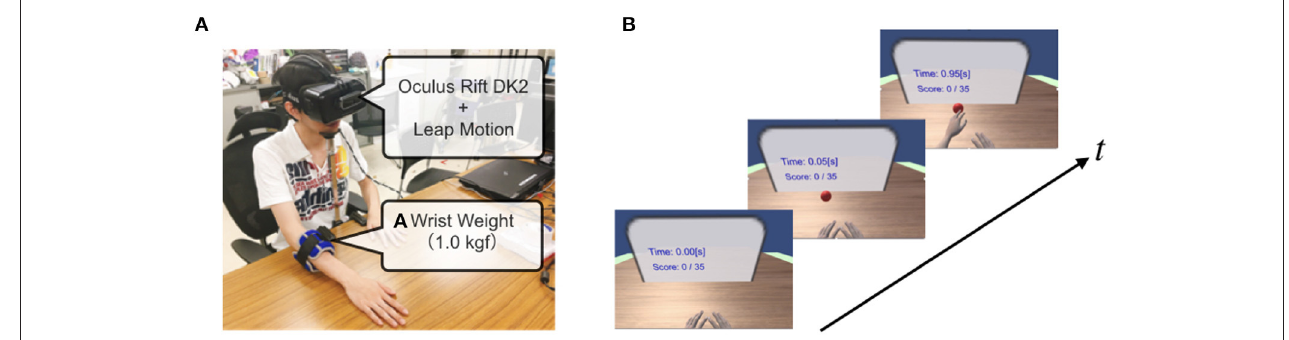
FIGURE 1 | Immersive Virtual Reality system integrated with motion capture. (A) A 1.0 kg wrist weight was attached to the distal portion of the dominant forearm of the healthy participant to simulate the affected upper limb of stroke patients. A head-mounted display (HMD) was attached to the head with a strap, and a motion capture system (Leap motion) was attached to the front part of the HMD. (B) The participant placed their hands at the home positions, and the target appeared randomly along with the semi-circle. The participant was asked to reach for the target immediately by choosing their virtually impaired or unaffected hand.